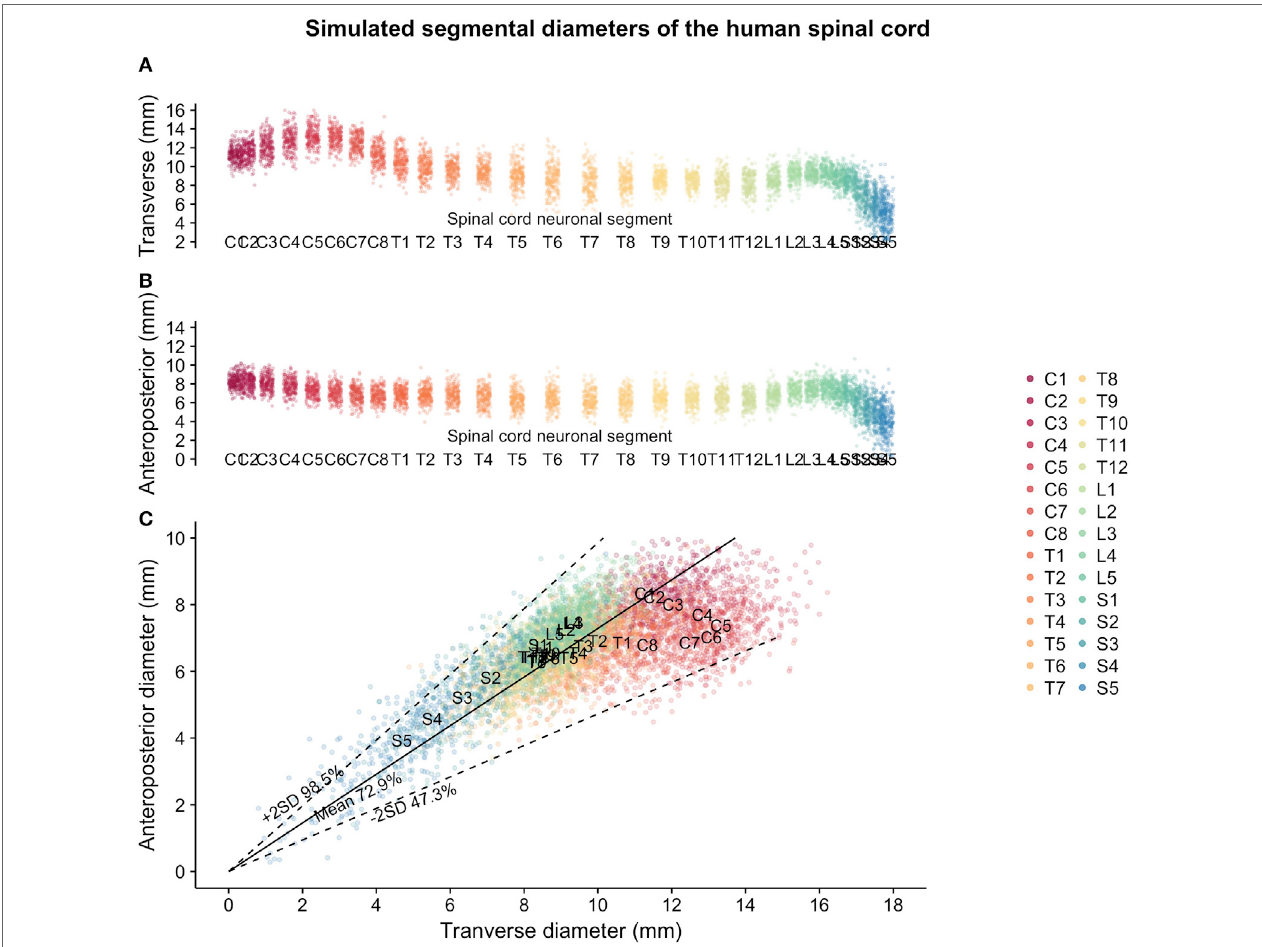
FigUre 1 | Simulated spinal cord sizes based on population estimates from Frostell et al. 2016: (a) transverse diameter of the human spinal cord per neuronal segment, (B) anteroposterior diameter of the human spinal cord per neuronal segment, and (c) relationship between transverse and anteroposterior diameters of the human spinal